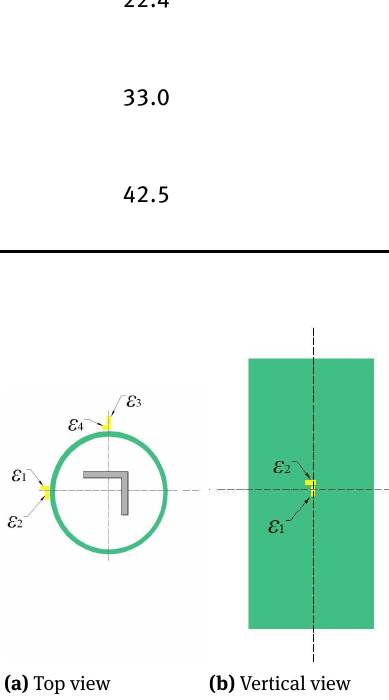
Figure 5: Arrangements of strain gauges